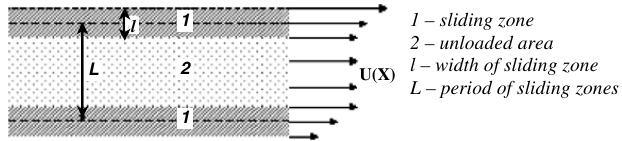
Fig. 4. Model of heterogeneous flow.